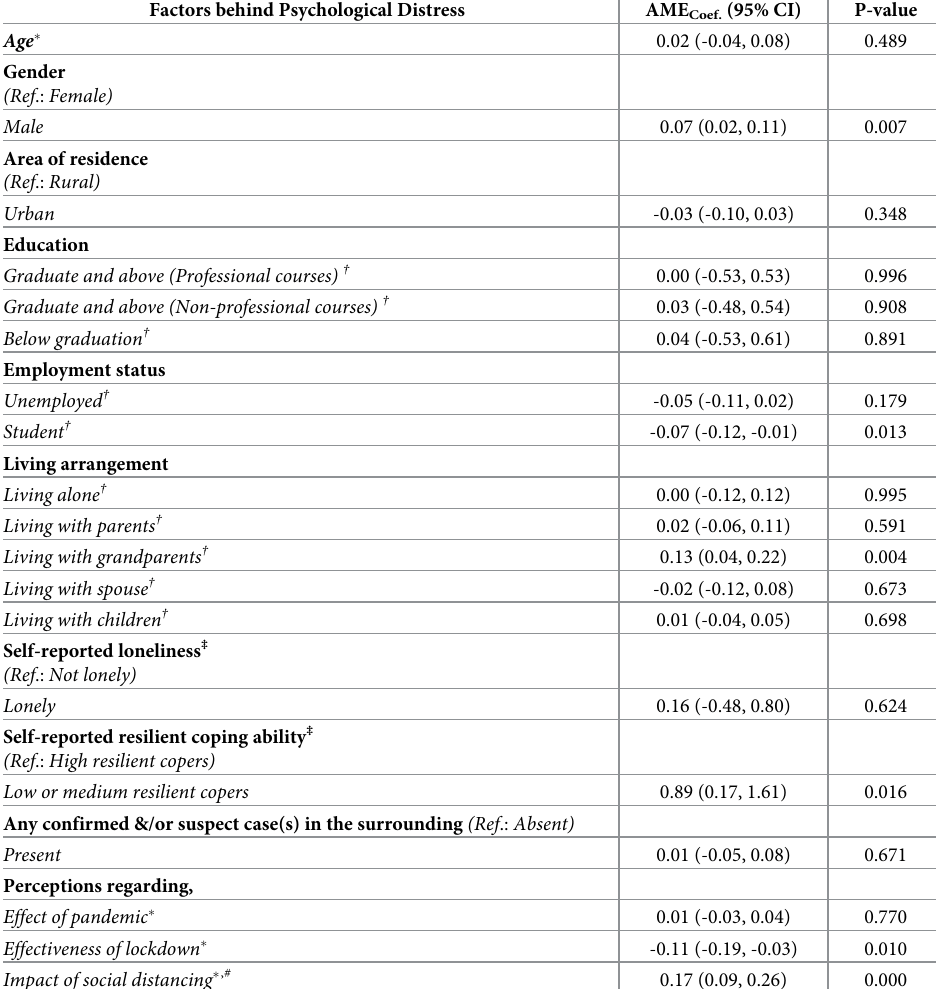
Table 5. Factors associated with psychological distress among the respondents. Factors behind Psychological